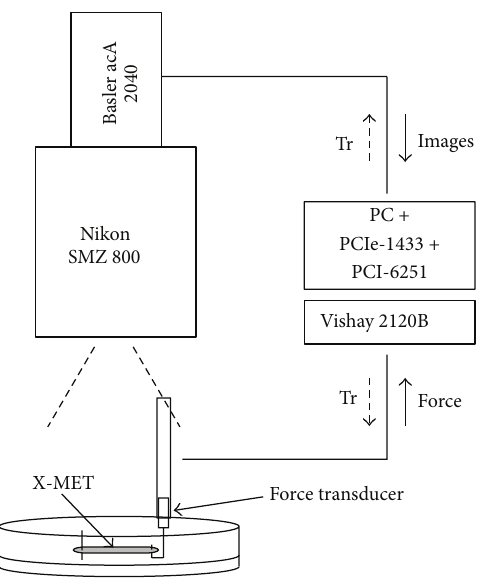
Figure 1: Experimental set-up. Main instruments and data flows of the experimental system. The personal computer (PC) is equipped with a data acquisition board (PCI-6251)and a frame grabber (PCIe- 1433), triggering (Tr) both image and force data